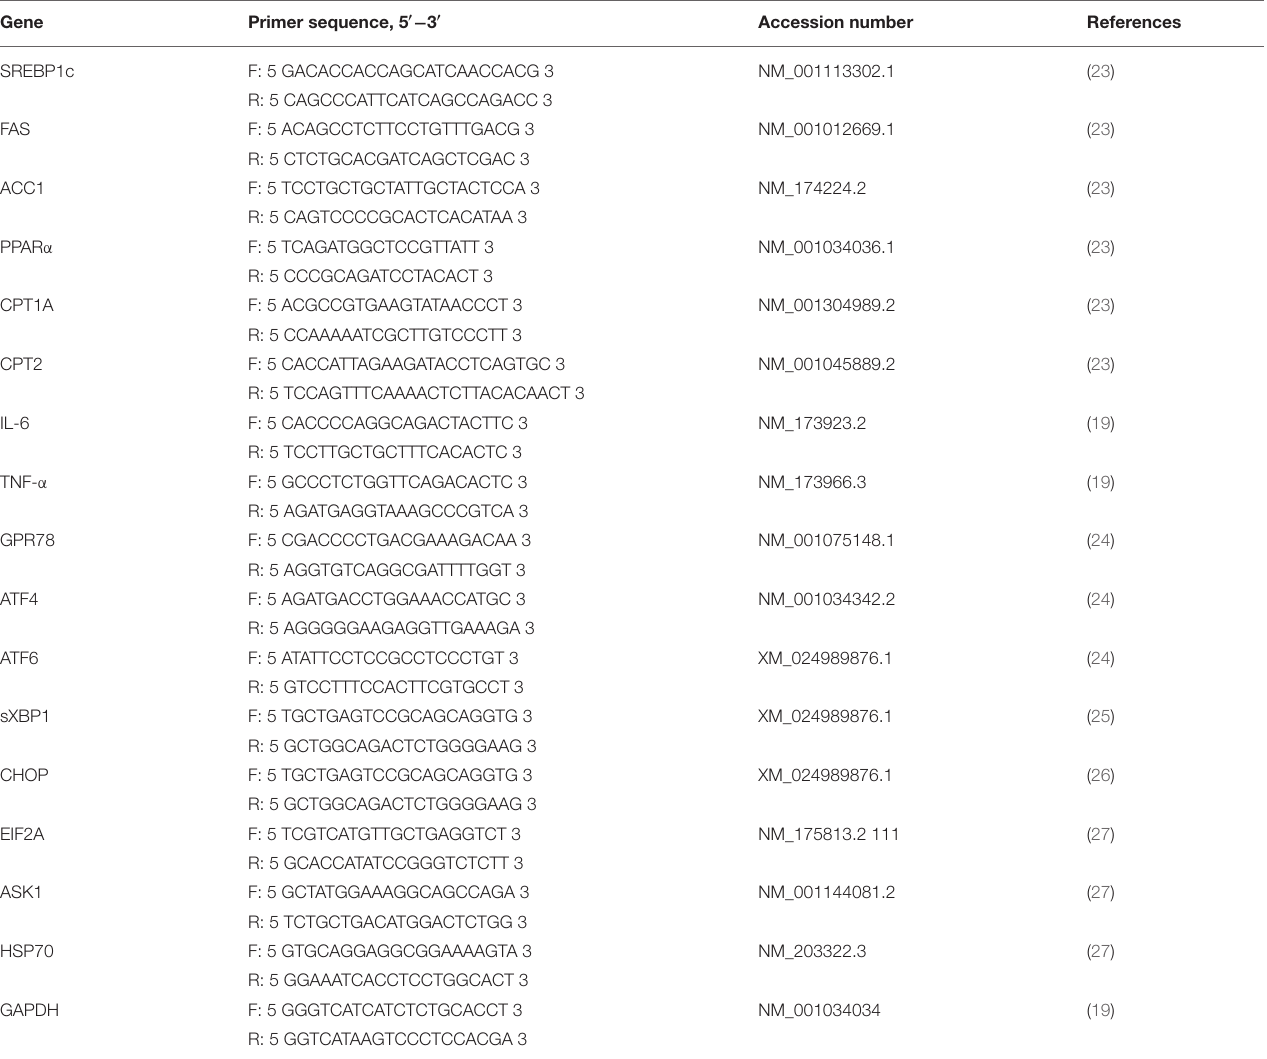
TABLE 1 | Primers for real-time PCR analyses.